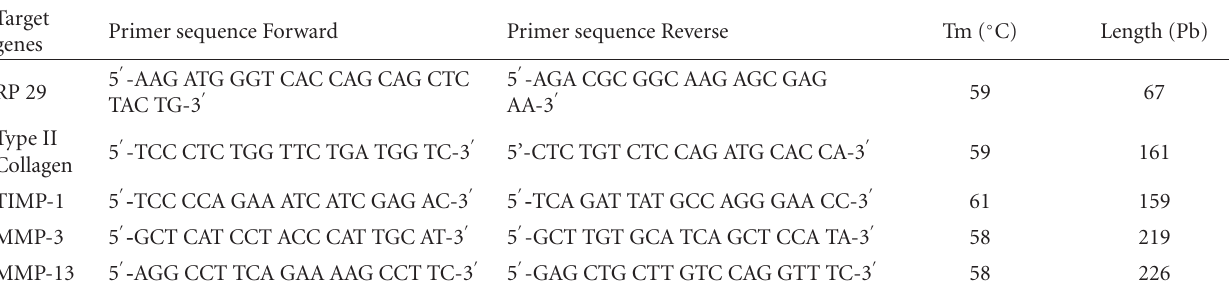
Table 1: Primers used for real-time PCR and corresponding product lengths.